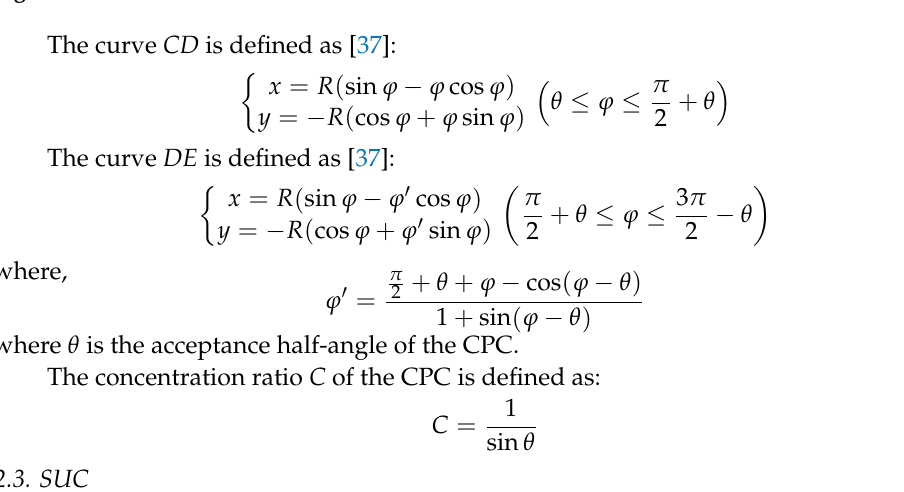
Figure 2. Schematic of a CPC model.